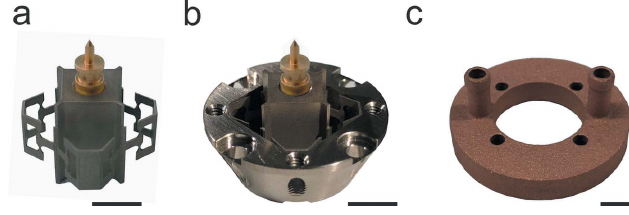
Figure 4 Modifications of the flOMNI sample holder. ( a ) An OMNY sample pin inserted into the new pin receptor with flexure structures designed to minimize heat transfer and mechanical stress to the laser interferometer mirror. ( b ) Receptor mounted in the conical mirror mounting piece. ( c ) 3D printed water cooler mounted to the back of the laser interferometer mirror. Scale bars: 5